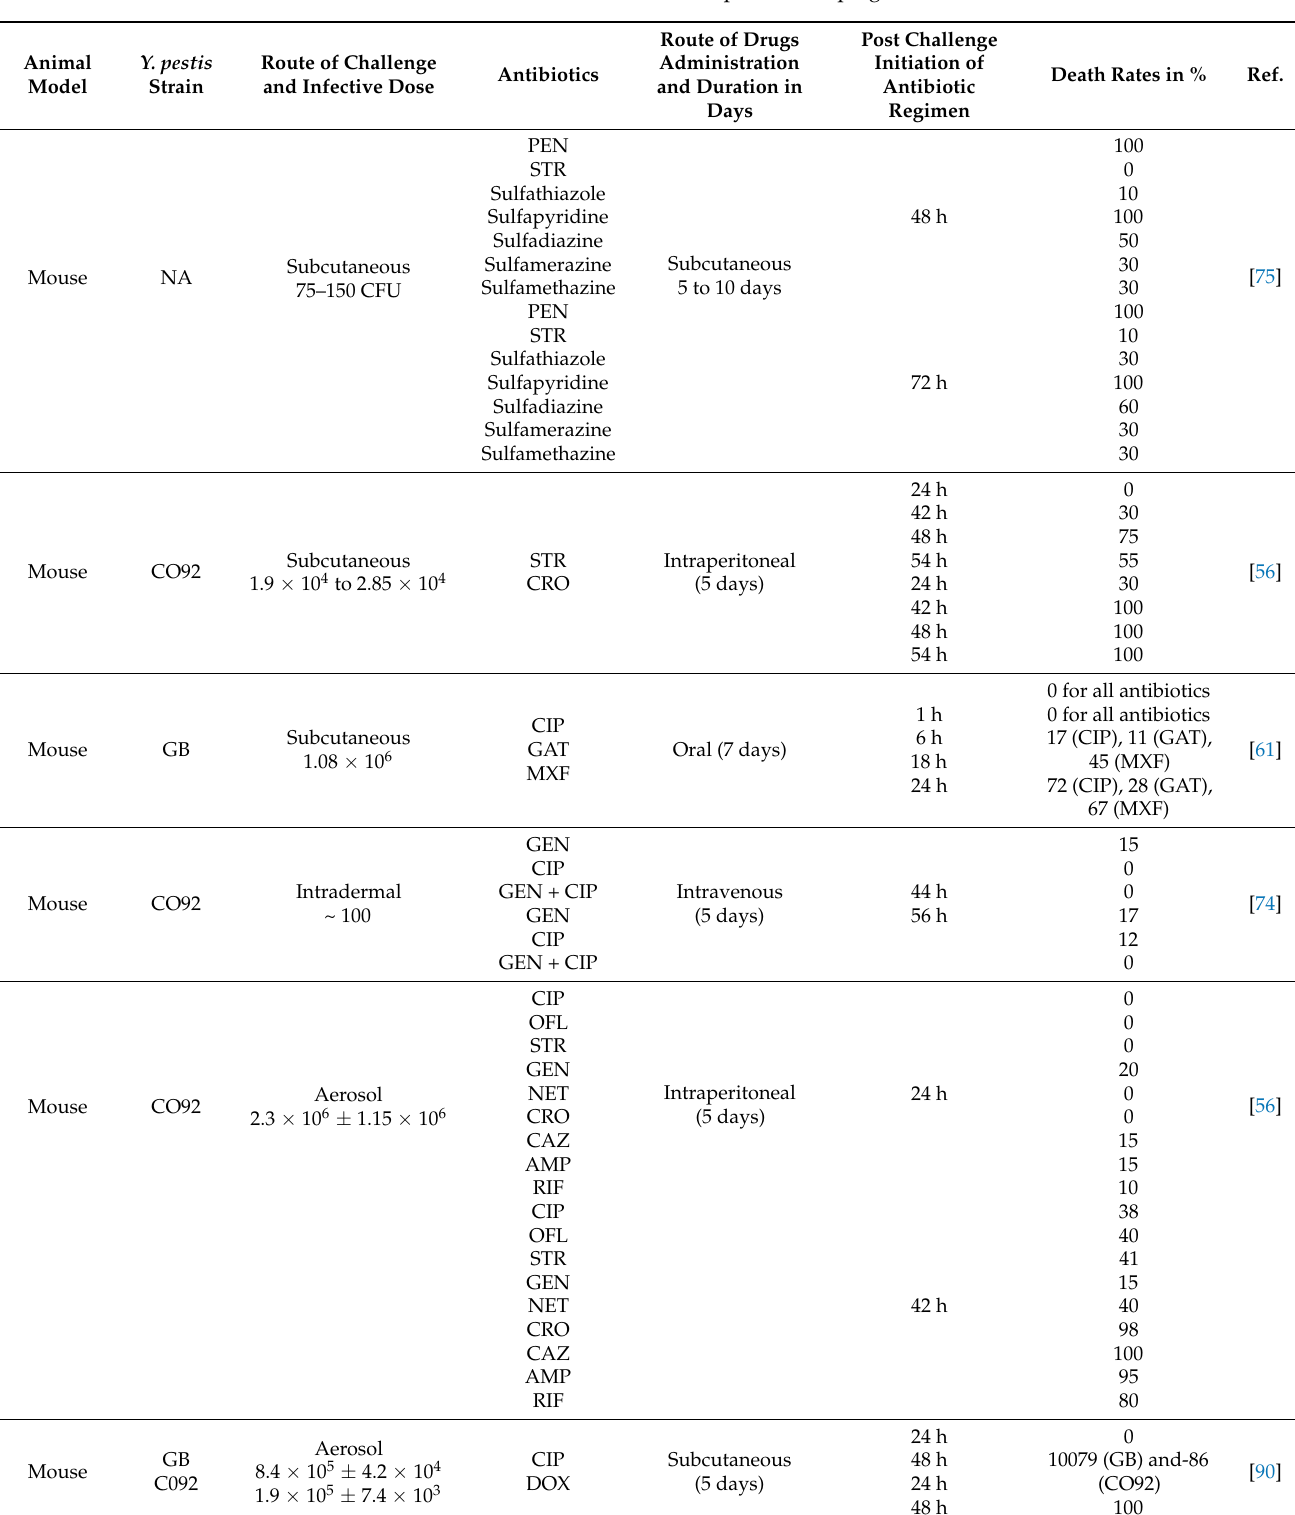
Table 2. Antibiotic treatment of experimental